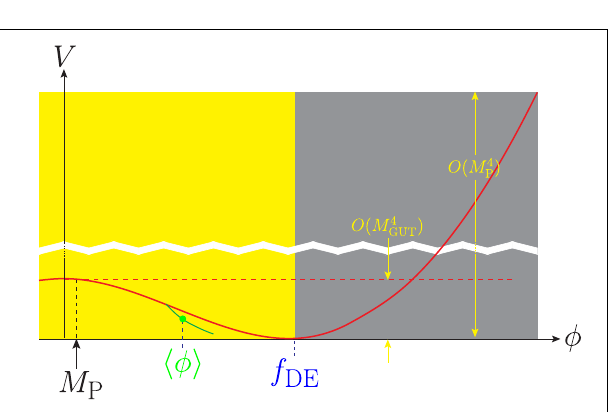
a term φ 104 / M 100 can be possible if the discrete symmetries allow P it. But with the trans-Planckian value, for example (cid:5) φ (cid:6) ∼ 31,